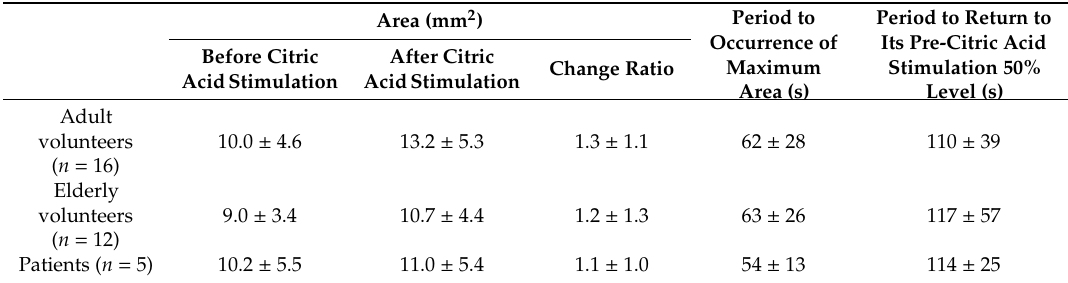
Table 4. Summary of physical and dynamic MR sialographic data.